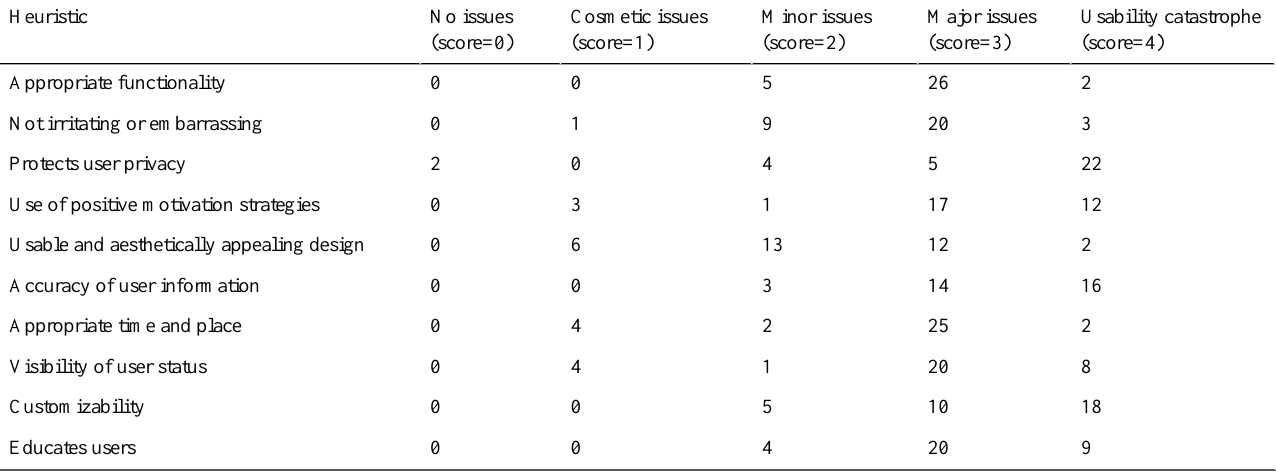
Table 5. Number of apps receiving usability severity scores for each persuasive health technology